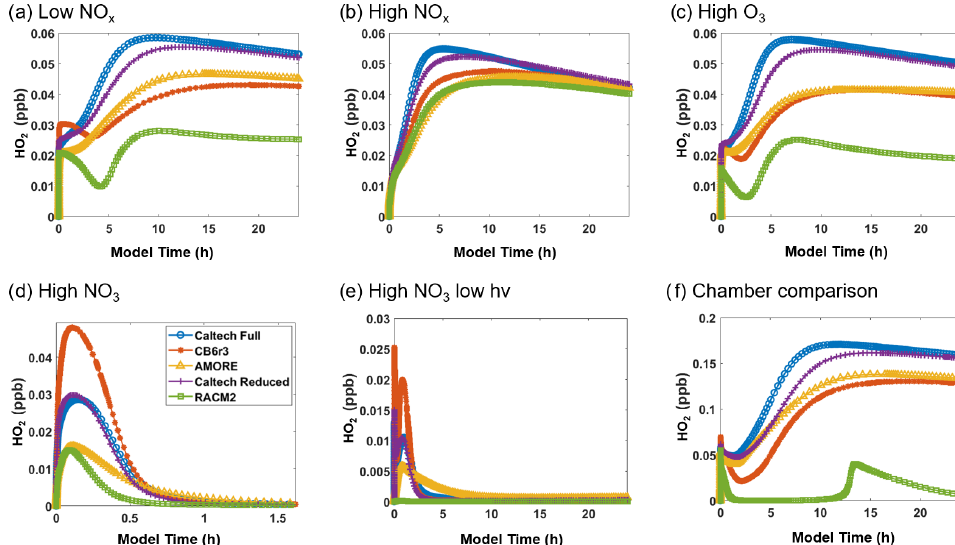
Figure 4. Box model predictions of HO 2 from multiple mechanisms (292K and 1000hPa) under the following conditions: (a) low NO x ;